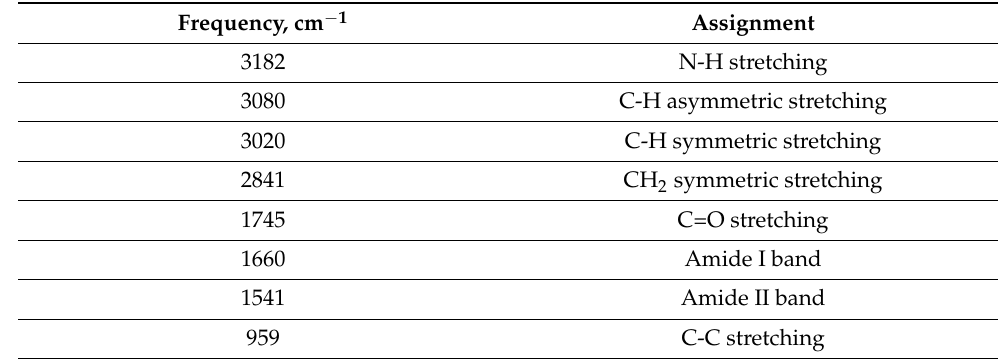
Table 2. FTIR spectra and assignment of nylon-66.